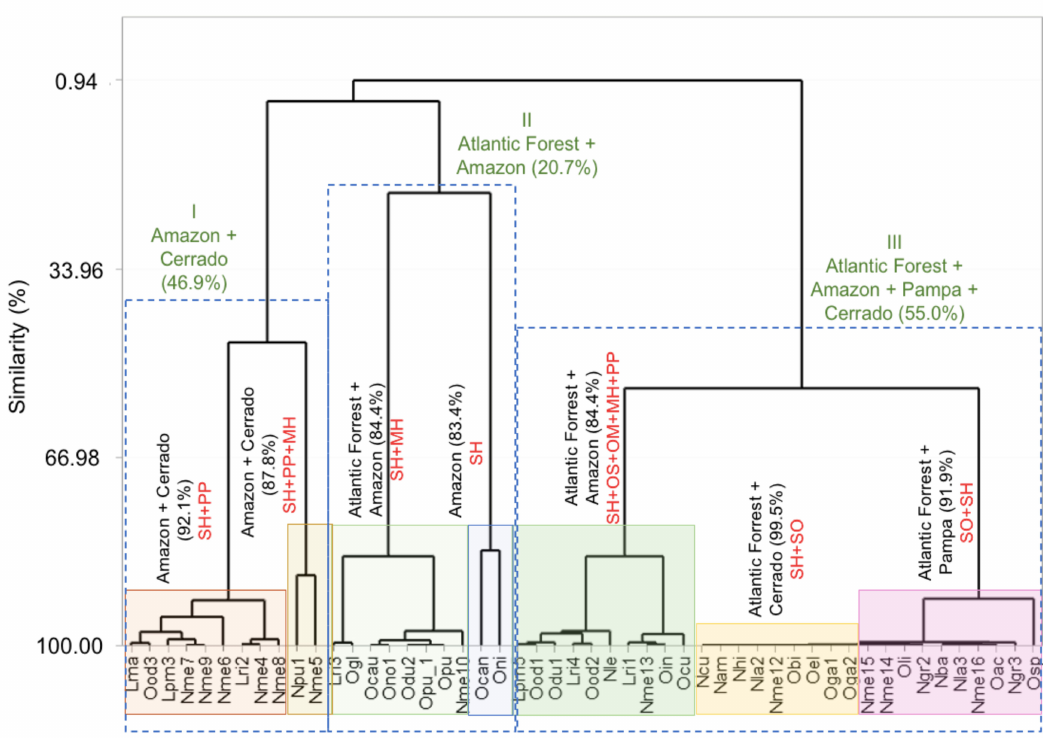
Figure 5. Dendrogram representing the similarity relationship in the oil compositions and geographical occurrence of species of Licaria , Nectandra and Ocotea collected in Brazilian biomes. Licaria